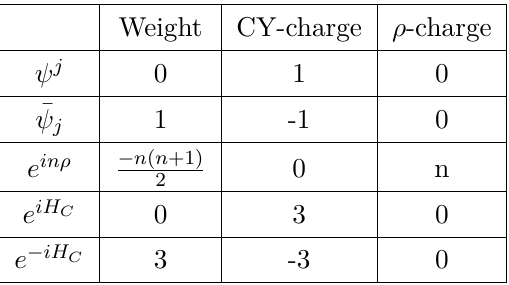
Table 1 . Conformal weight, CY-charge and ρ - charge in the twisted case.